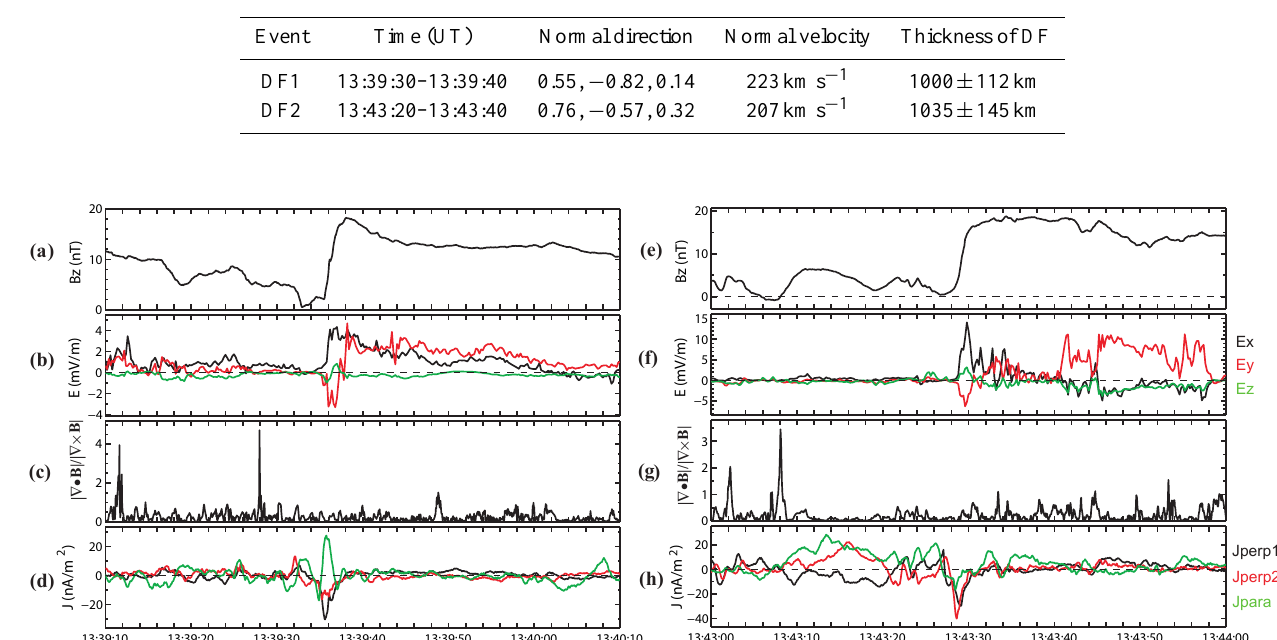
Table 1. Timing analysis results.